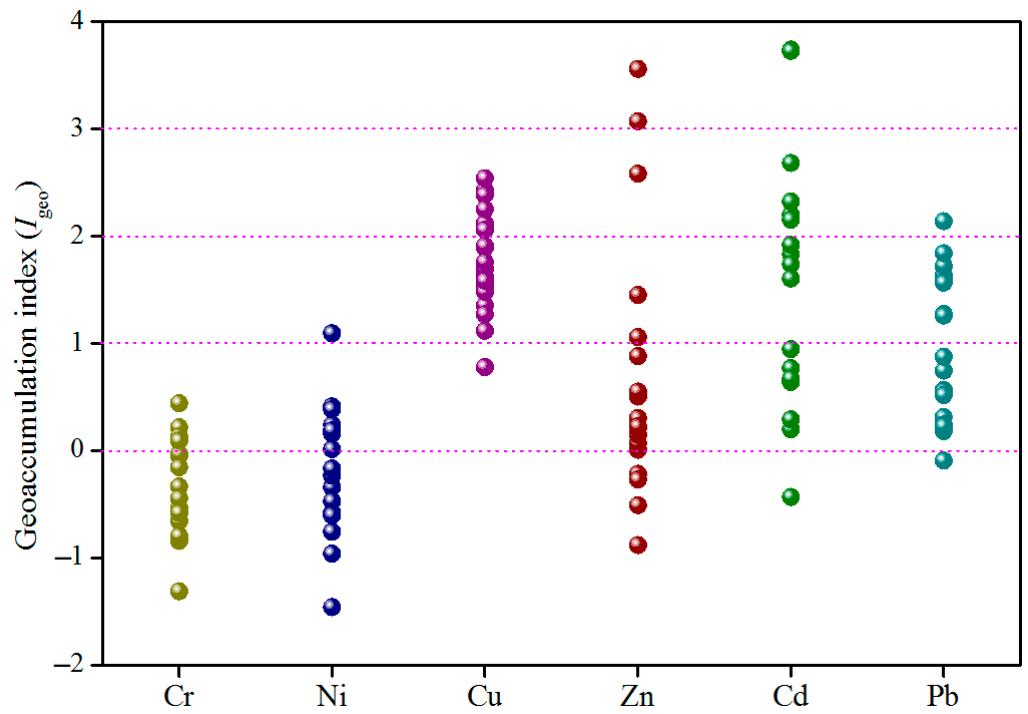
Figure 5. Geoaccumulation index for elements in sediments of Shantou Bay.